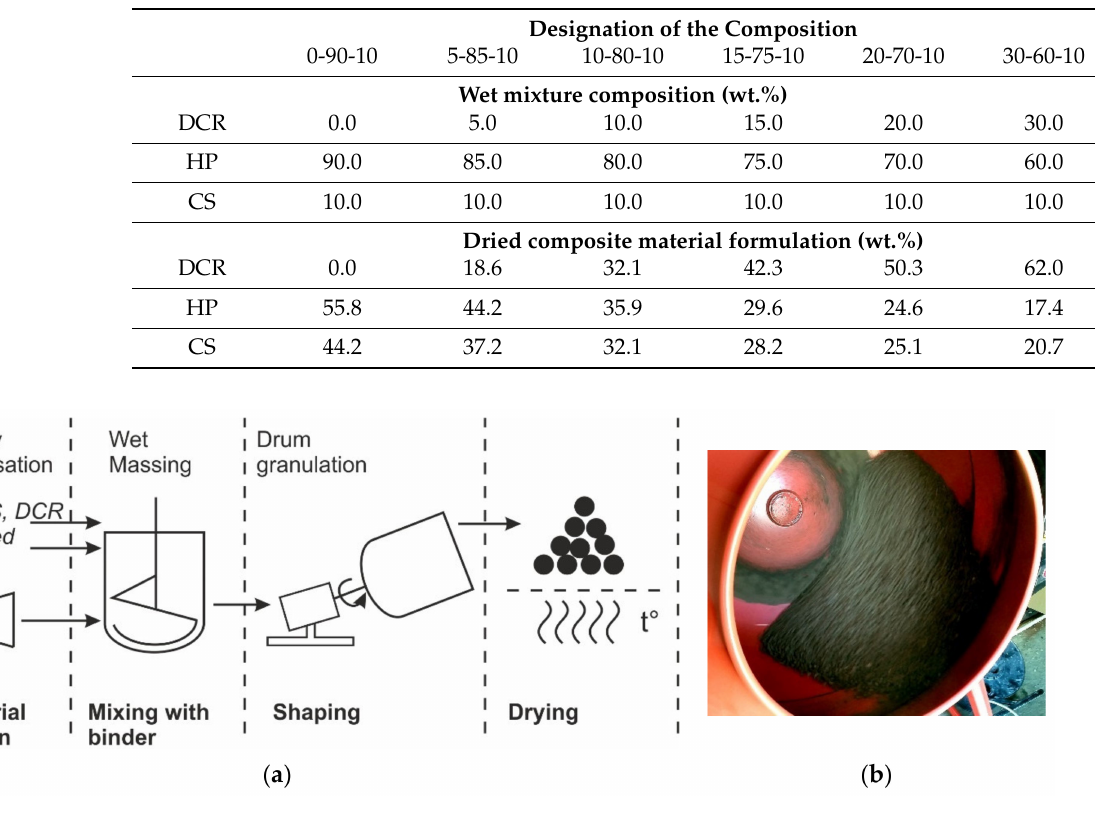
Figure 1. Production scheme ( a ) and used drum granulator ( b ) in